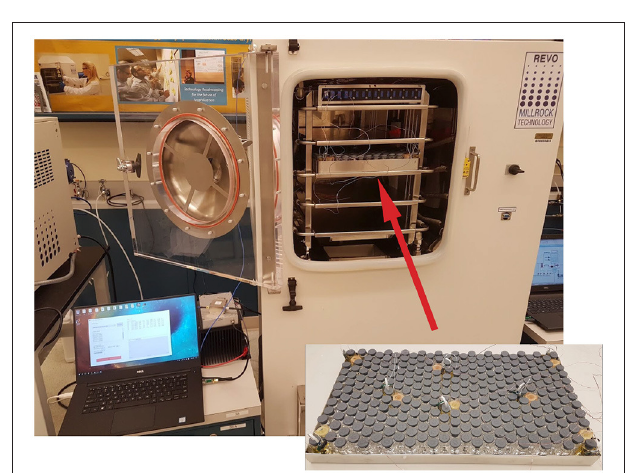
FIGURE 3 | Typical arrangement of the vials with sensors and thermocouples in the tray and into the freeze dryer.